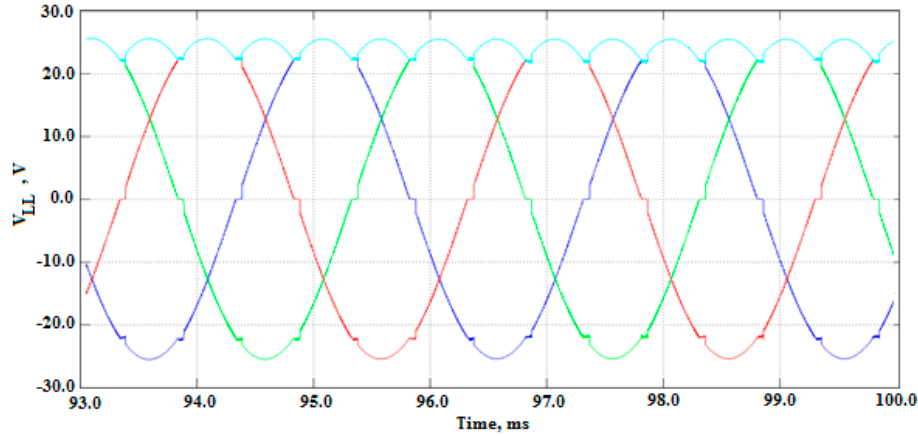
Figure 15. Simulation results for open circuit rectifier output voltage at 5000 rpm at firing angle α = 0.